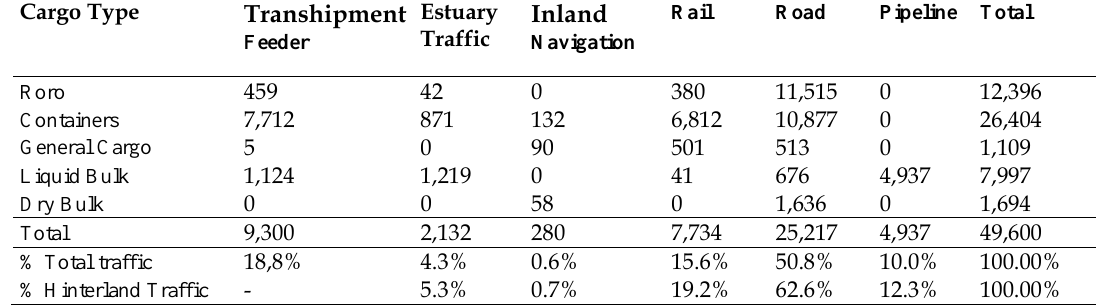
Table 1. Port of Zeebrugge (2010): modal split in 10 3 ton (Port Authority Zeebrugge, 2011).